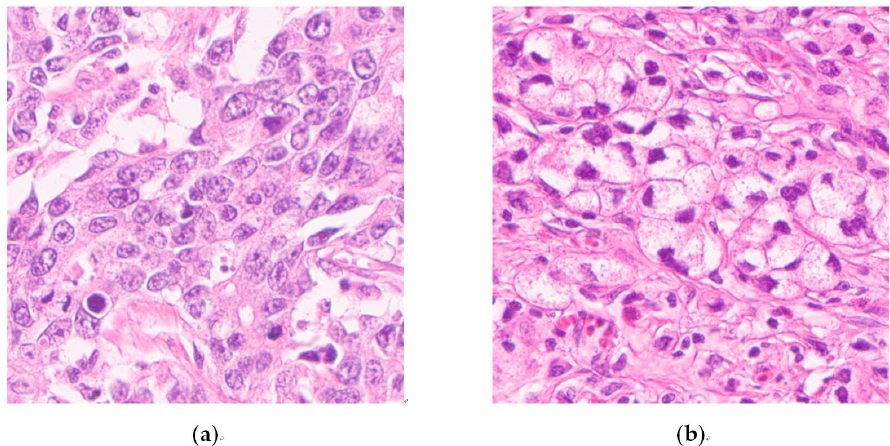
Figure 2. Representative images of cancer cell clusters of ≥5 carcinoma cells lacking glandular formation (magnification ×400). Image ( a ) is morphologically consistent with poorly differentiated carcinoma not otherwise specified, and image ( b ) is consistent with signet ring cell carcinoma.